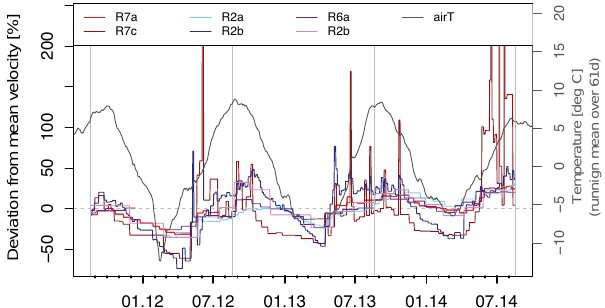
Figure 3. Intra-annual variability in horizontal velocities. Left y axis: intra-annual variability, expressed as deviation from MAV 12 − 14 . Right y axis: filtered air temperature (running mean over 61 days). Vertical grey lines separate the 3 different years of observation (2011/12, 2012/13, 2013/14).